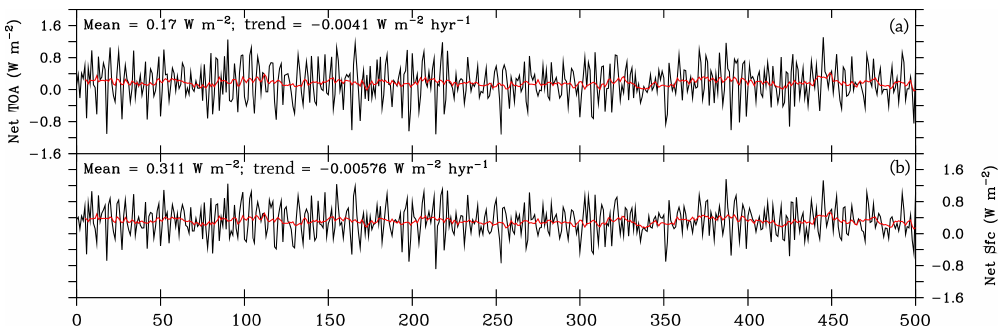
Figure 2. Radiative energy balances in NESM v3. Time series of the net radiative energy fluxes at TOA (downward, Wm − 2 , a ) and the net heat flux at the Earth surface (Wm − 2 , b ) from year 0 to 500 in the preindustrial control experiment. The long-term mean value and trend are indicated in the upper left corner. The black lines indicate annual mean values and the red lines indicate their 9-year running mean